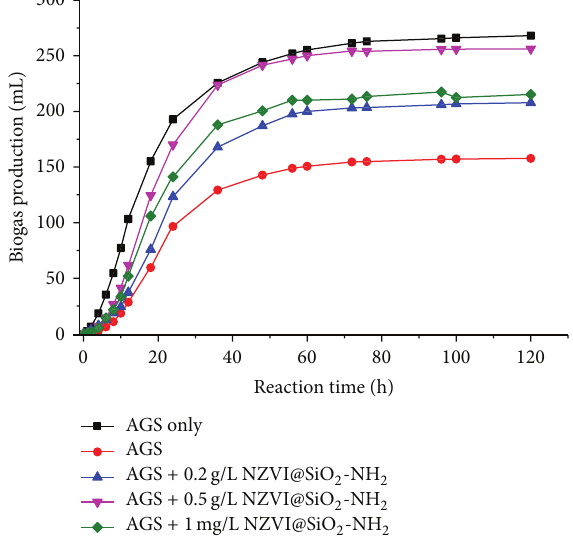
Figure 10: The production curves of CH 4 in different anaerobic treatment process with and without NZVI@SiO 2 -NH 2 at pH 7.0.